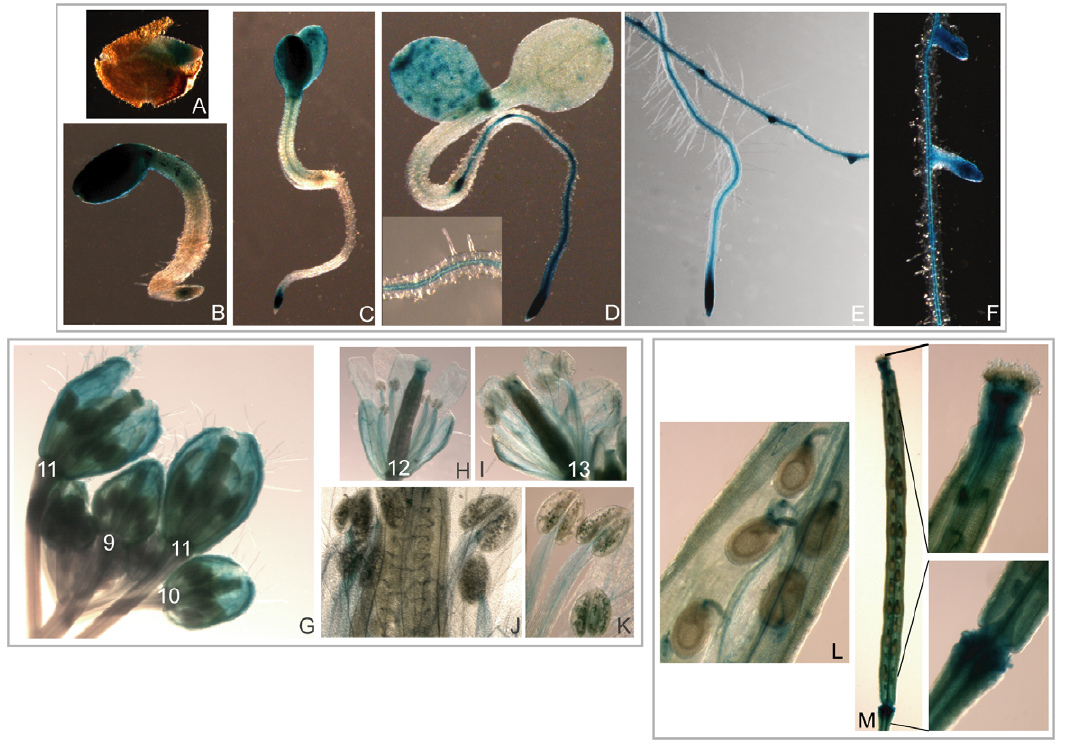
Figure 6. Histochemical analysis of GUS activity driven by the AtAucsia -1 promoter in A.thaliana . (A–D) GUS activity at different stages of germination. (A) embryo at mature cotyledon stage; (B) seedling 1 day after germination (dag); (C) 3 dag seedling, (D) 4 dag seedling, a particular of the primary root vasculature is reported in the inset; (E) and (F) 10 days old seedling, GUS staining patterns in emerged lateral roots. (G) stages 9–11 of flower development (for a description of the stages see results and [75]. (H–I) stages 12–13 of flower development; (J–K) stage 12–13, magnifications highlighting GUS expression in anther filaments. (L–M) growing silique approximately 1 cm long. (L) GUS expression in ovule funiculi, (M) GUS activity in the